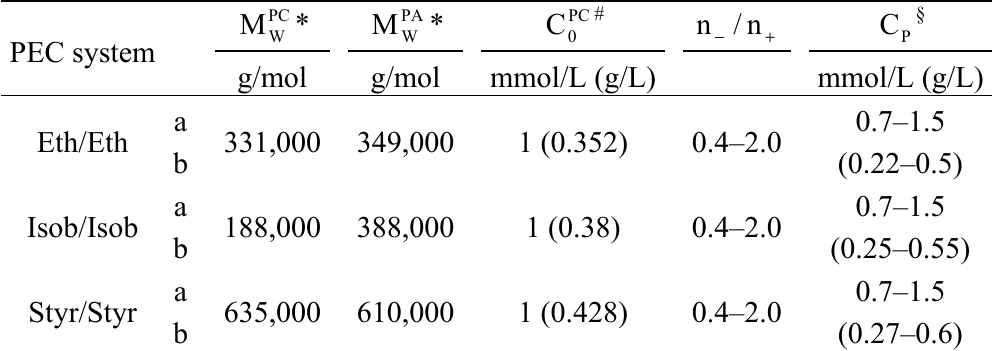
Table 1. Concentrations and molar ratios of Polyelectrolyte complexes (